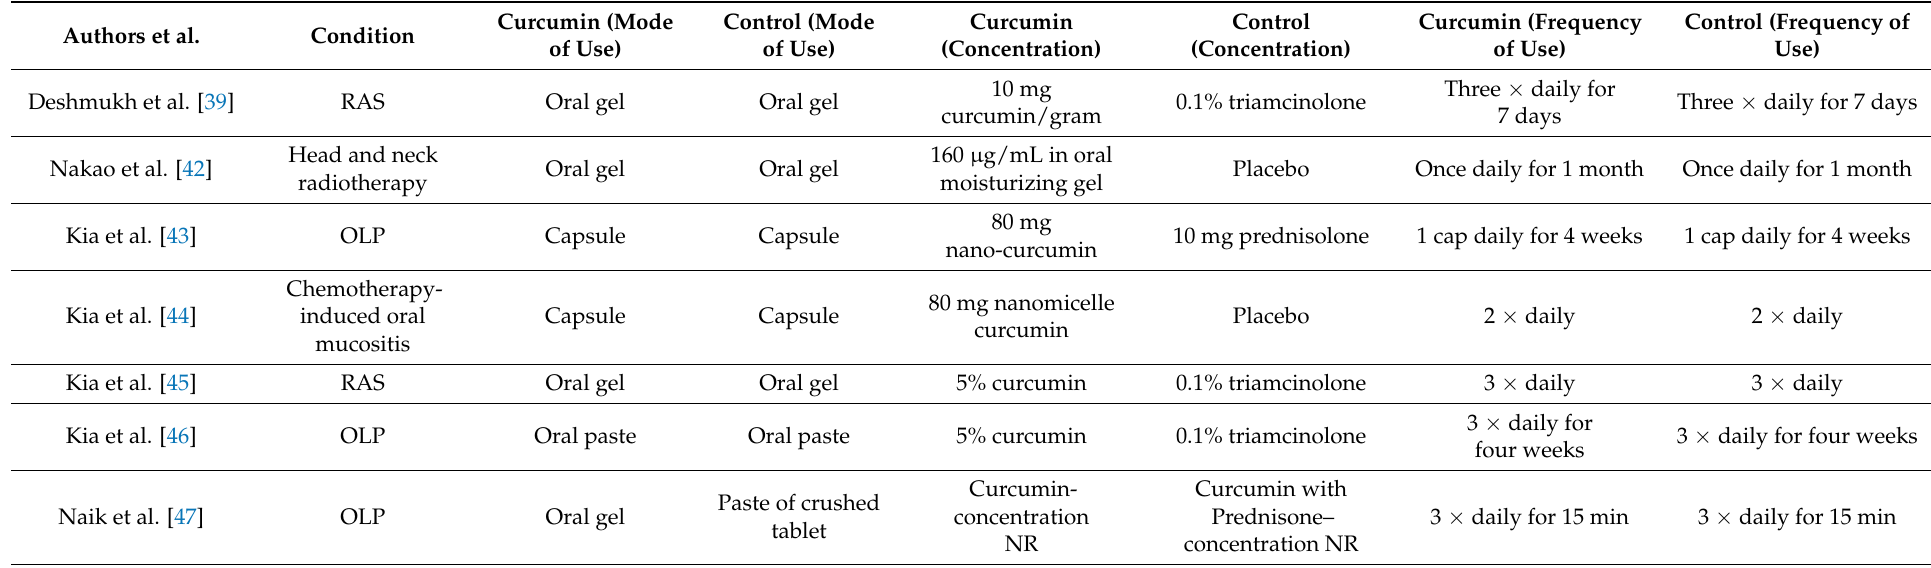
Table 2. Curcumin-related characteristics in studies with curcumin-only study